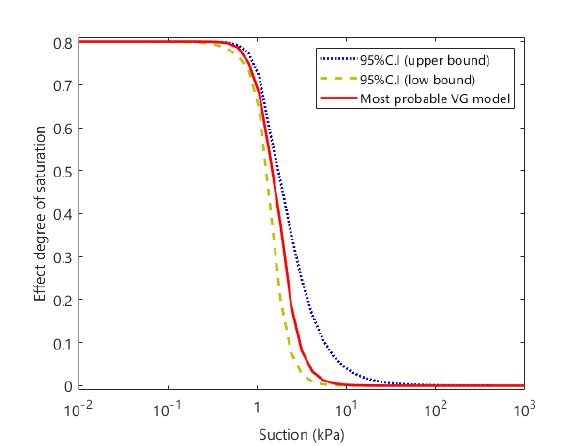
Figure 14. The 95% confidence interval of VG obtained from the Bayesian